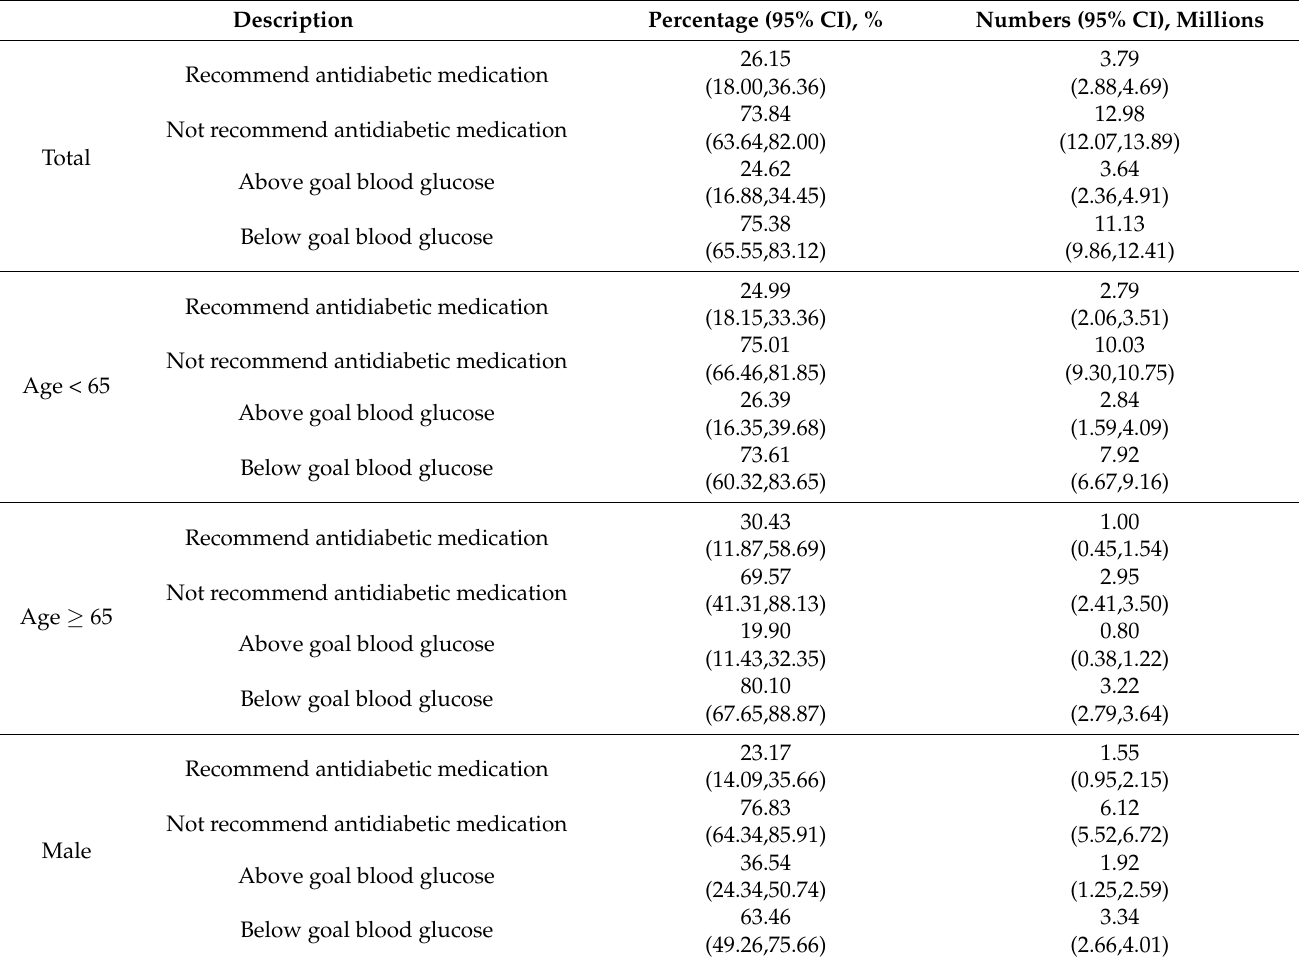
Table A1. Percentage and numbers of Chinese adults who take antidiabetic medication and of controls in patients with elevated BMI combined with